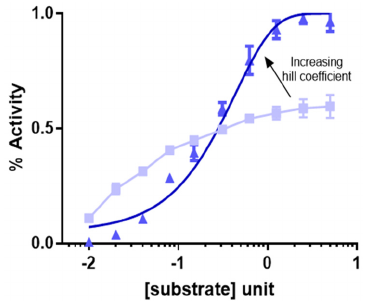
Figure 2. Hill co-efficient and sigmoidal curve. The light blue curve represents a classical Michaelis- Menten reaction kinetics, whereas the darker blue curve represents transformation of the Michaelis- Menten reaction kinetics in presence of cooperativity and hill coefficient. The steeper slope that the inflexion of the sigmoidal curve has the higher the hill coefficient for co-operativity.